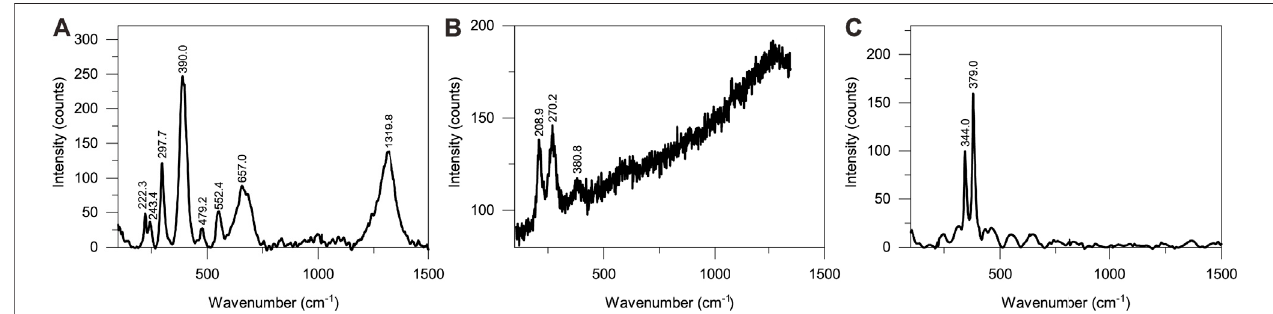
FIGURE 3 | Raman spectrum of the limestones from the Zongpu Formation. Three types of Fe-O-S minerals (hematite, goethite and pyrite) can be identi fi ed in the Raman spectra, respectively.